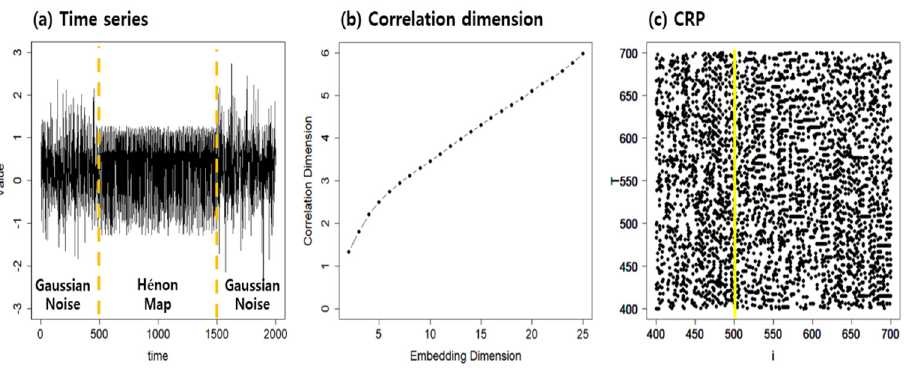
Figure 13. ( a ) Combined time series of Gaussian noise and the Hénon map; ( b ) correlation dimension; ( c ) yellow line represents the boundary between the Gaussian noise and the Hénon map.